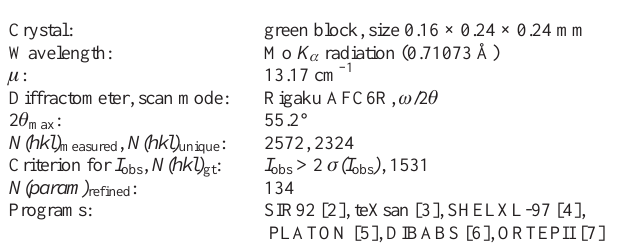
Table 1. Data collection and handling.